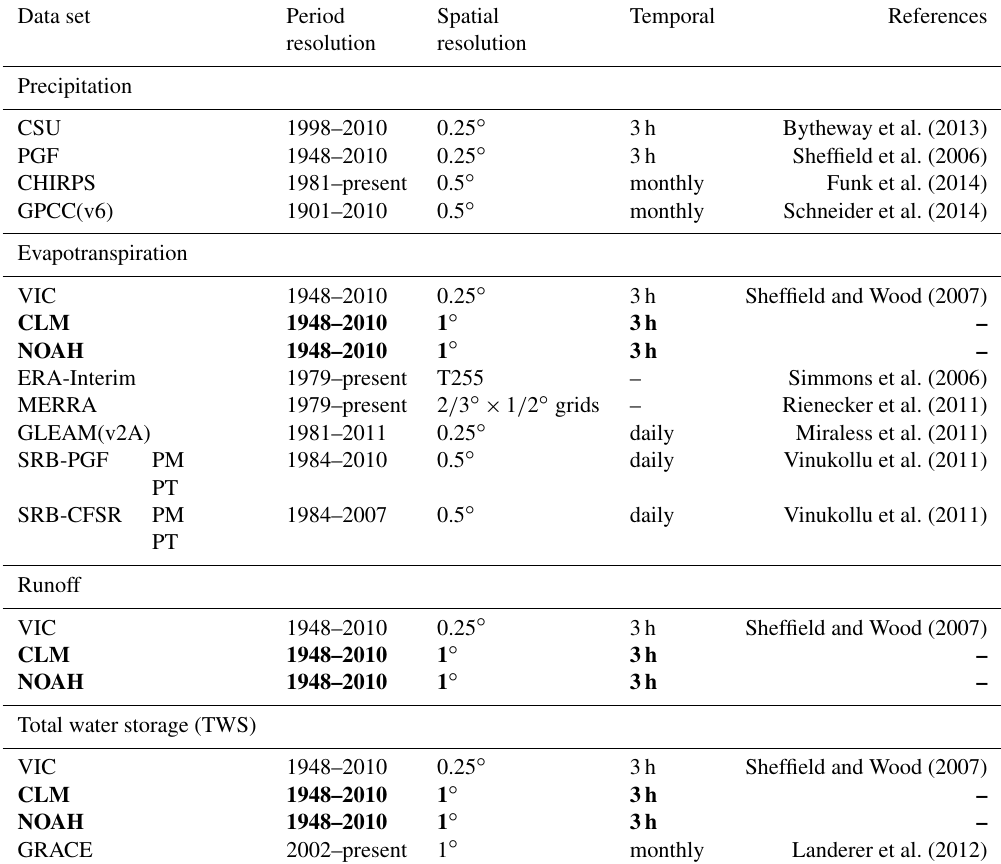
Table 1. Summary of the gridded data used in this study. (The study period is 1984–2010; CLM and NOAH, written in bold, are analyzed but not merged into the final water budget CDR in this